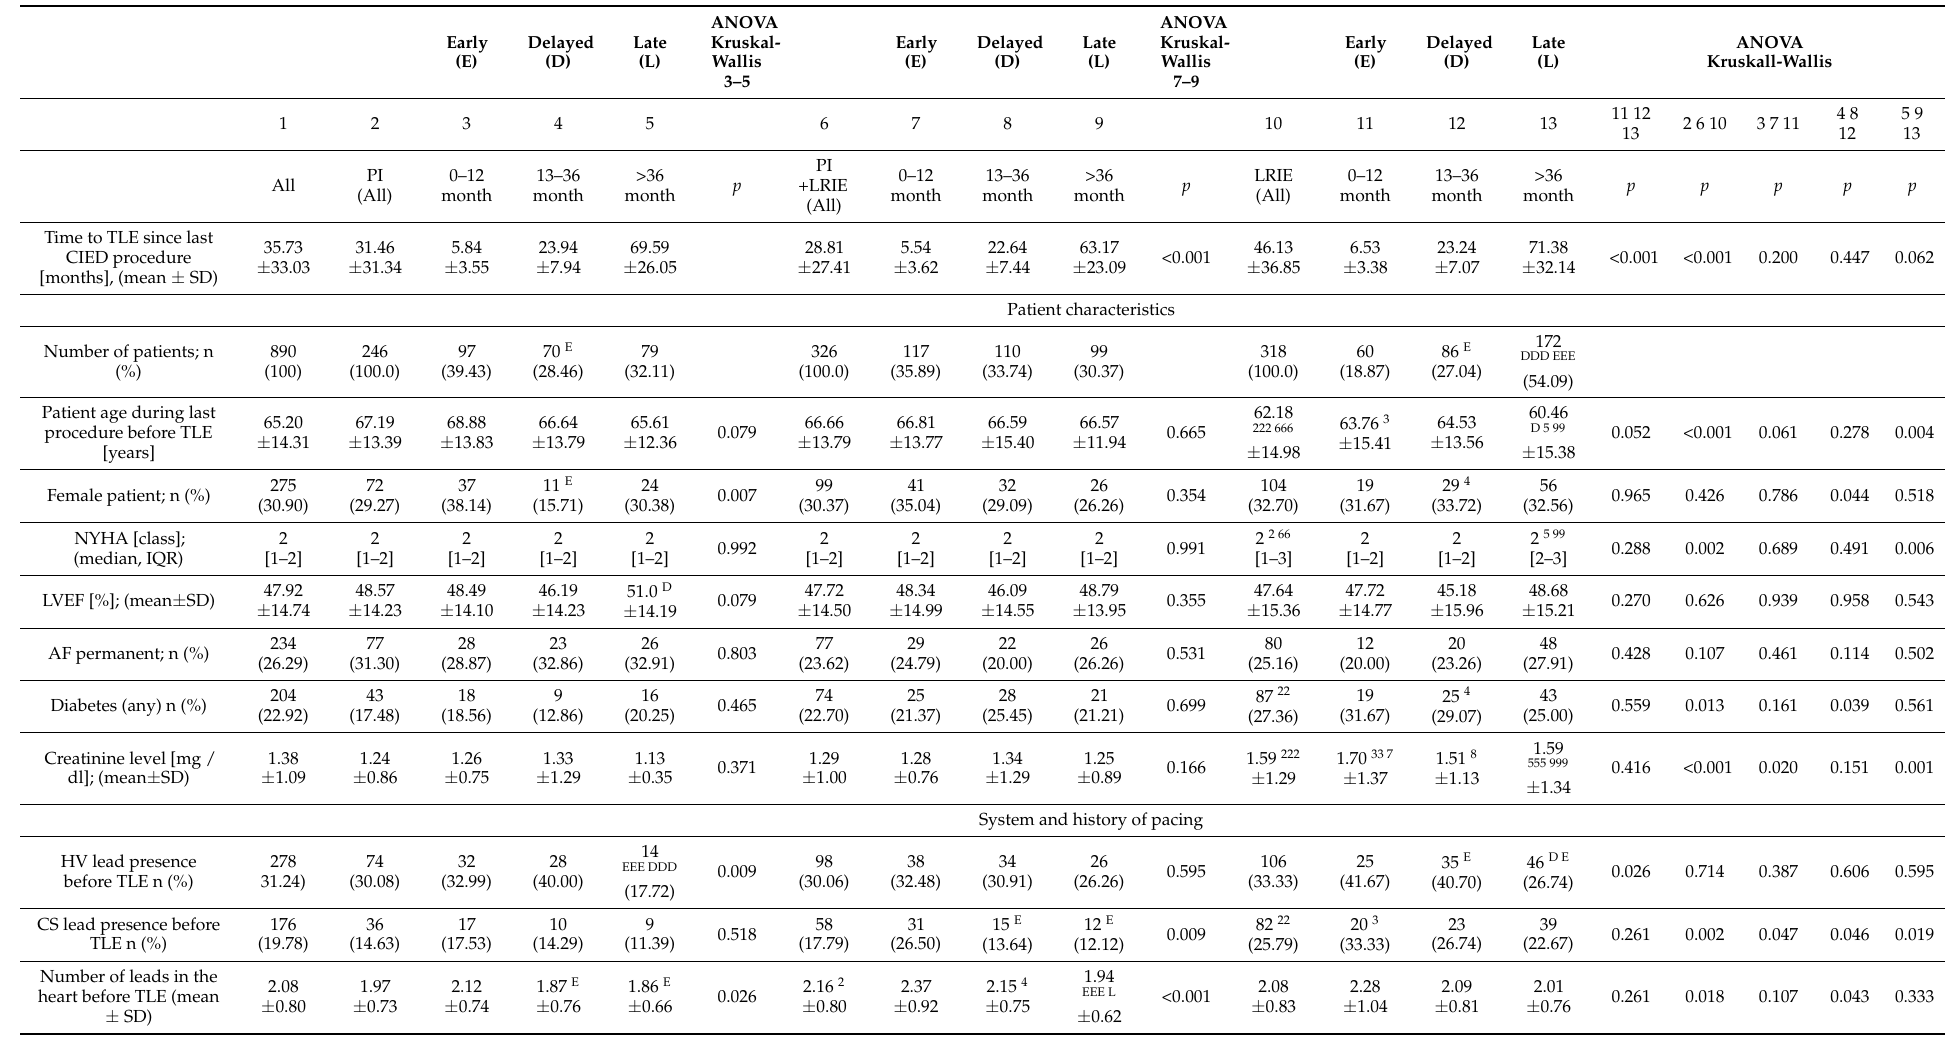
Table 2. Clinical and procedural findings depending on type of infection and temporal onset related to last CIED procedure for noninfectious